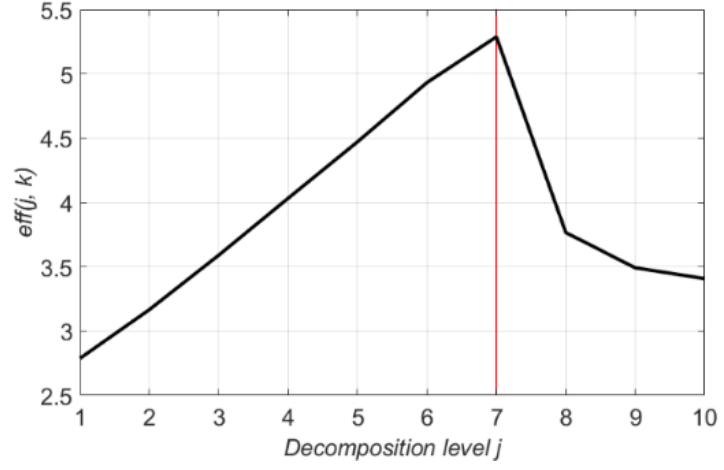
Figure 8. 𝑒𝑓𝑓(𝑗,𝑘) values of 10 decomposition levels (1 to 10) for db9. Figure 8. ef f ( j , k ) values of 10 decomposition levels (1 to 10) for